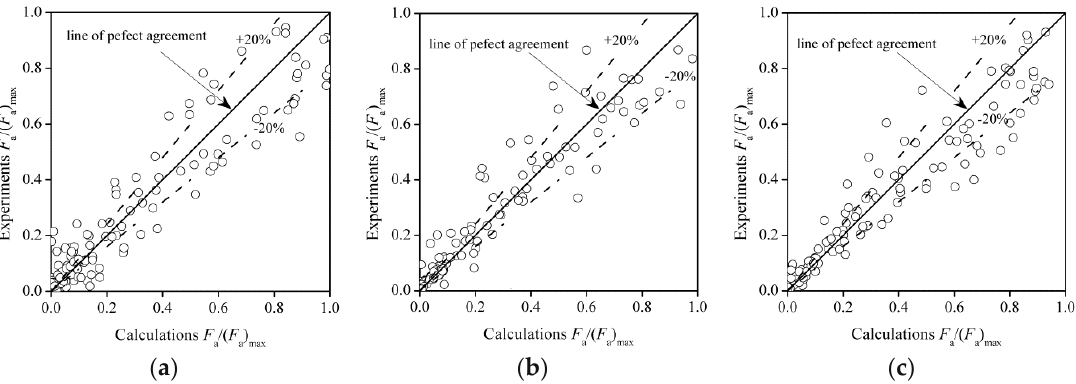
Figure 8. Comparison of experimental data with calculated values of dimensionless air bubble frequency. ( a ) upper nappe; ( b ) lower nappe; ( c ) side nappe.